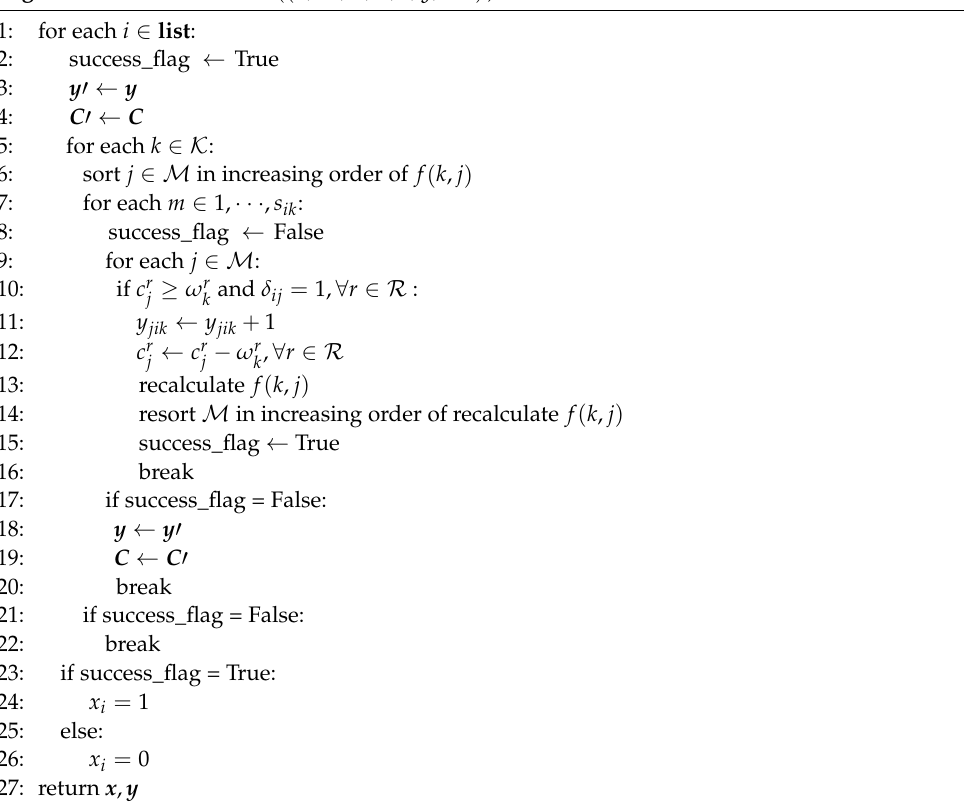
Algorithm 3 Task_schedule (( S , W , ∆∆∆ , C , x , y , list )